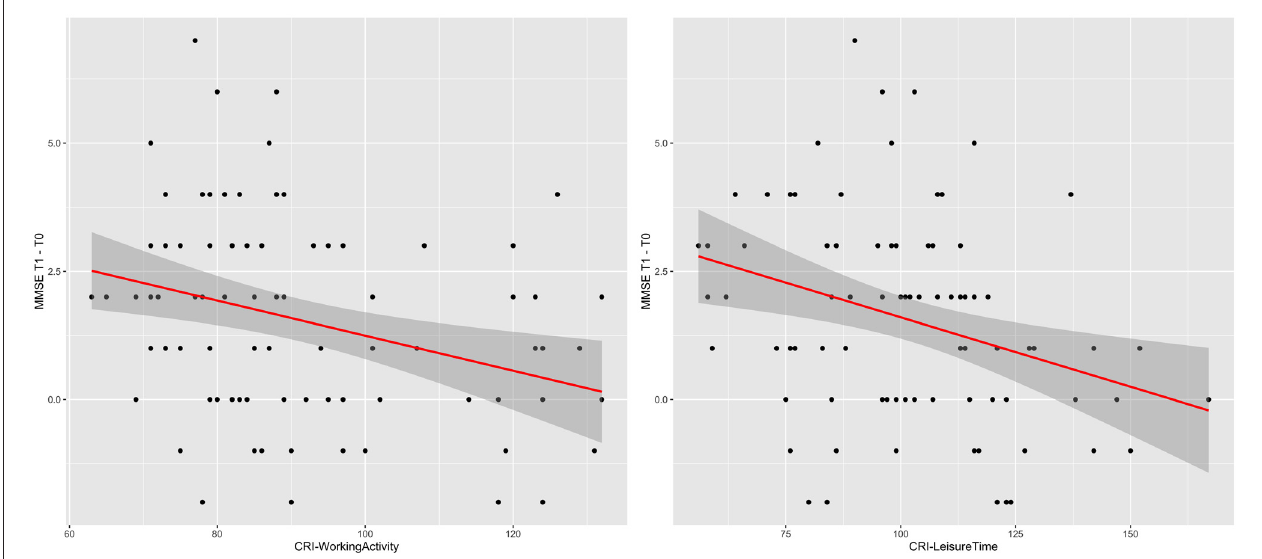
FIGURE 2 | CRI-Working Activity and CRI-Leisure Time effects. Graphical representation of the effects of CRI-Working Activity and CRI-Leisure Time on the difference in MMSE score between T1 and T0, according to Model 14. The line indicates the regression line and the gray area indicates its 95% C.I.